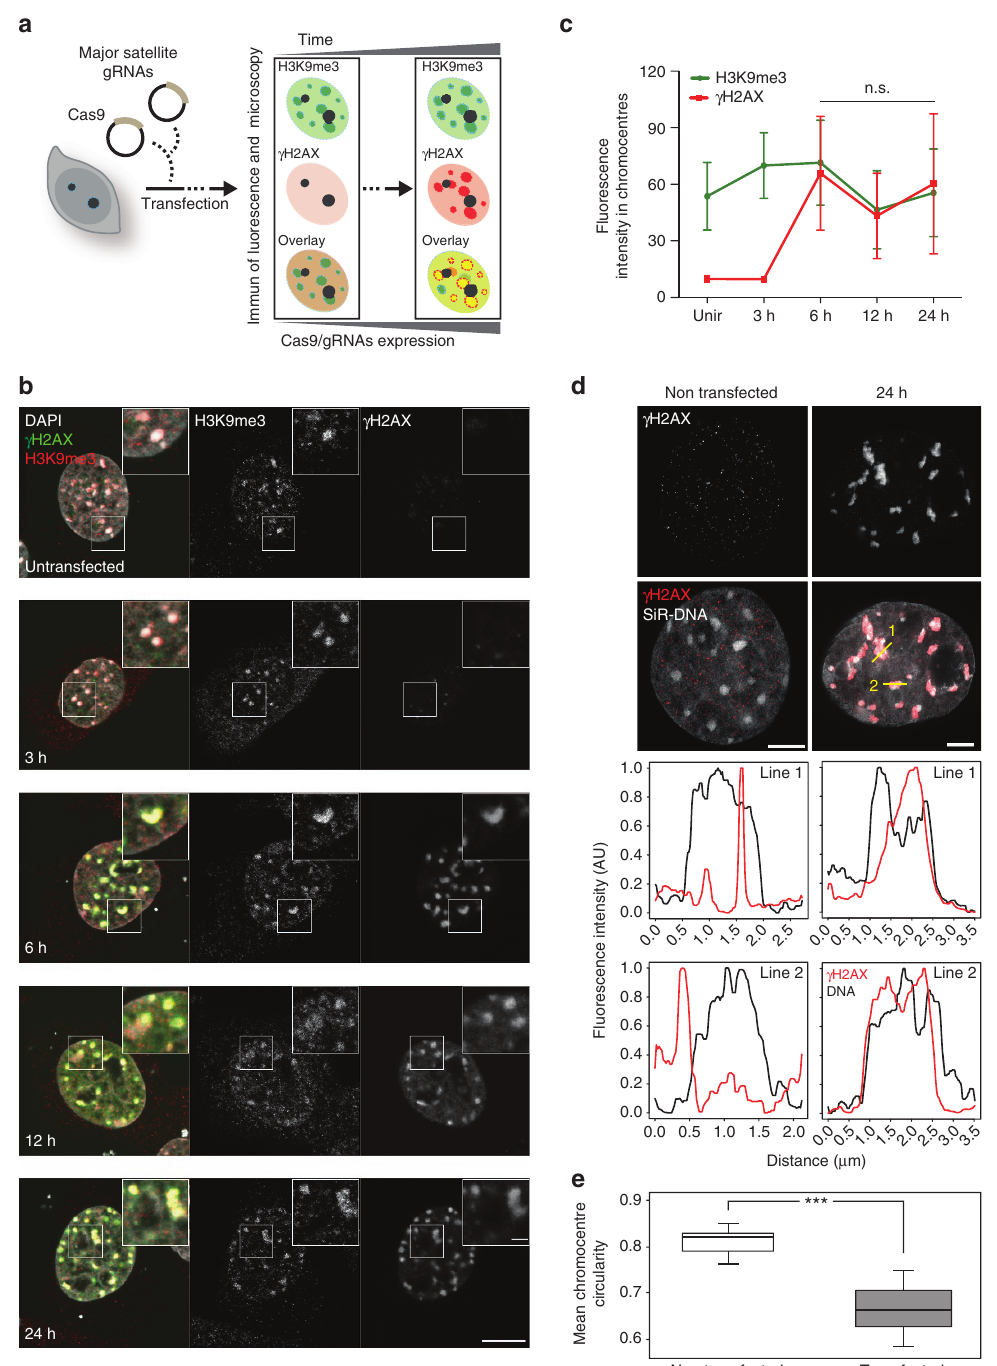
Figure 5 | Analysis of c H2AX and H3K9me3 levels at heterochromatin-targeted CRISPR-Cas9-mediated DSBs. ( a ) Schematics of the CRISPR-Cas9- mediated DSBs induction at murine major satellites DNA. C2C12 cells were transfected with Cas9 and major satellites gRNAs plasmids and fixed after the indicated times. ( b ) Representative immunofluorescence images of g H2AX and H3K9me3 in C2C12 cells. Scale bars, 10 m m and 2 m m for micrograph and inset, respectively. ( c ) Quantification of g H2AX and H3K9me3 fluorescence intensity from DAPI-segmented chromocentres. Mean and s.d. from ( b ) are shown. n ¼ 5 cells (2–19 chromocentres), 5 cells (6–15 chromocentres), 5 cells (8–19 chromocentres), 5 cells (13–19 chromocentres) and 4 cells (9–19 chromocentres), for untransfected, 3h, 6h, 12h and 24h time points, respectively. See image analysis in the ‘Methods’ section for details. ( d ) Representative STED immunofluorescence images of g H2AX and SiR-labelled DNA as indicated. Yellow lines: line profiles (shown below). For the latter, fluorescence intensities were normalized to the min–max range of values of each profile. Lines were smoothed by a 5-window running median. ( e ) Chromocentres decondensation after major satellite-targeted Cas9, assessed as mean chromocentre circularity in transfected ( n ¼ 9) and untransfected ( n ¼ 10) cells. For each cell, the circularity of chromocentres ( 4 100px 2 ) within the nucleus was determined as described in the ‘Methods’ section, yielding shape information for 165 (transfected cells) and 148 (untransfected cells) chromocentres. Statistics: Wilcoxon rank sum test (*** P o 10 (cid:2) 3 ). Scale bar, 2 m